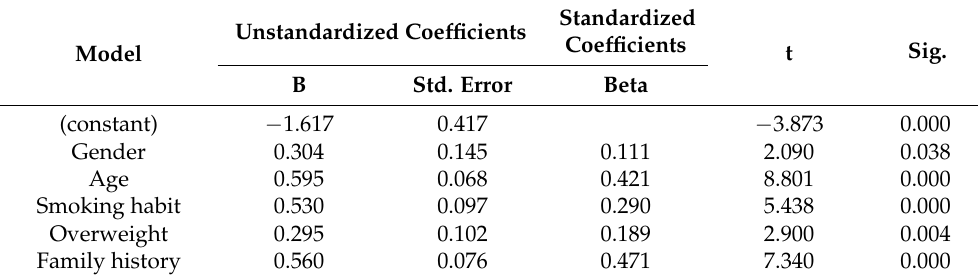
Table 9. Multilinear Regression Test Results/Coefficients.